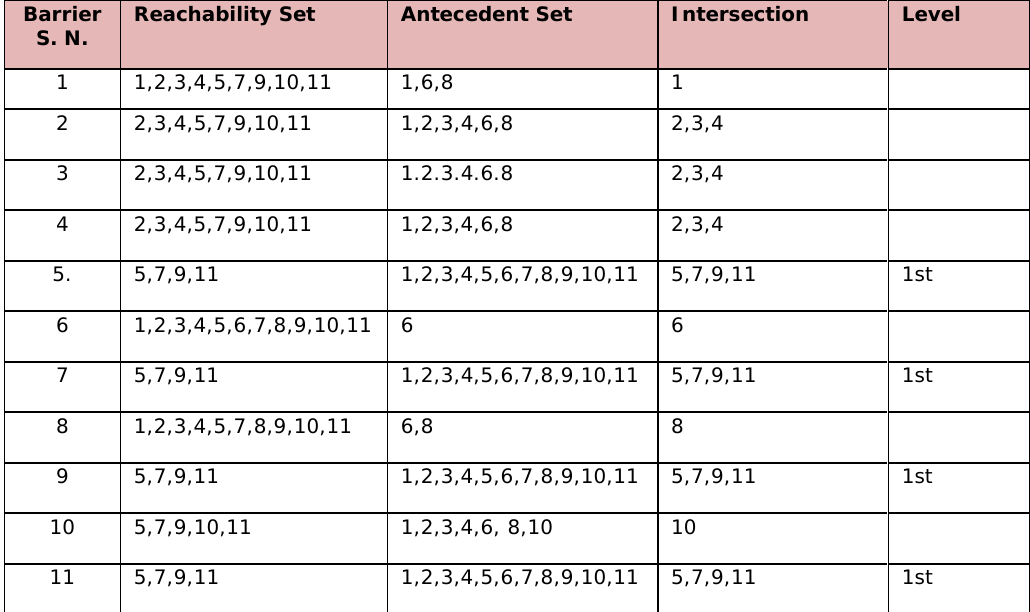
Table 6. “First Iteration to FIND LEVELS of Barriers to Implement GSCM in Indian Automobile